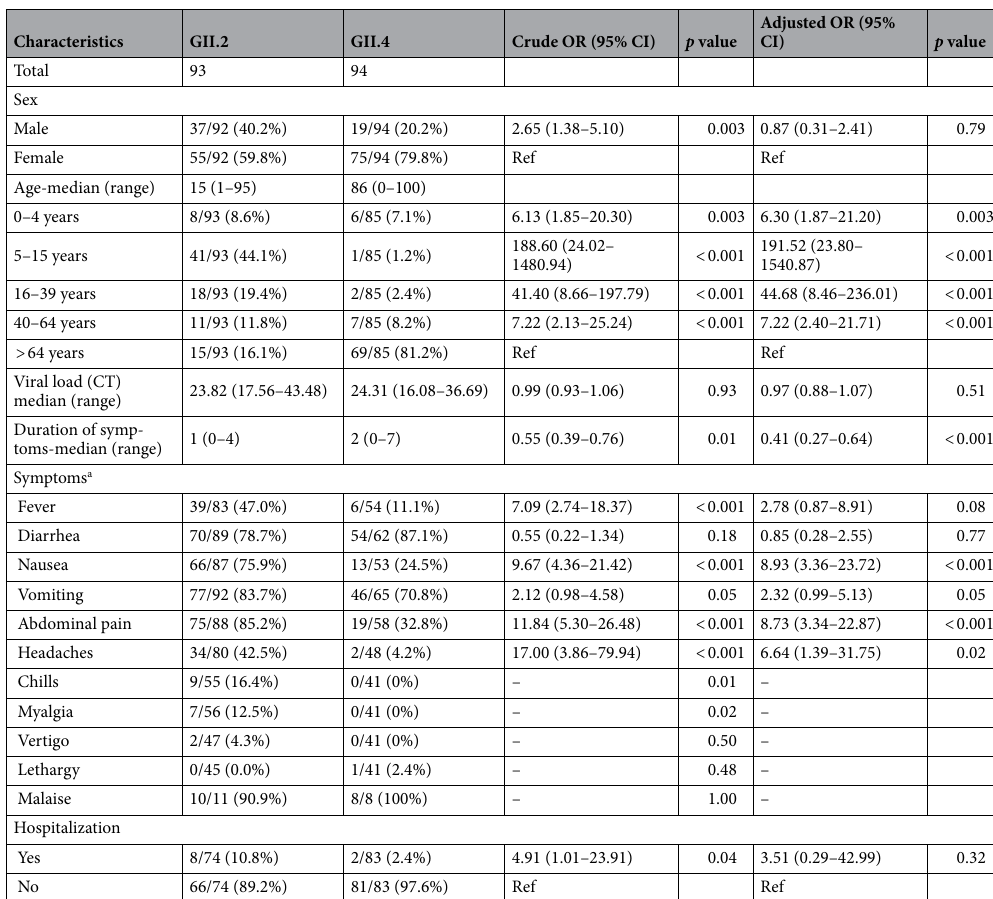
Table 4. Characteristics persons affected by GII.2 and GII.4